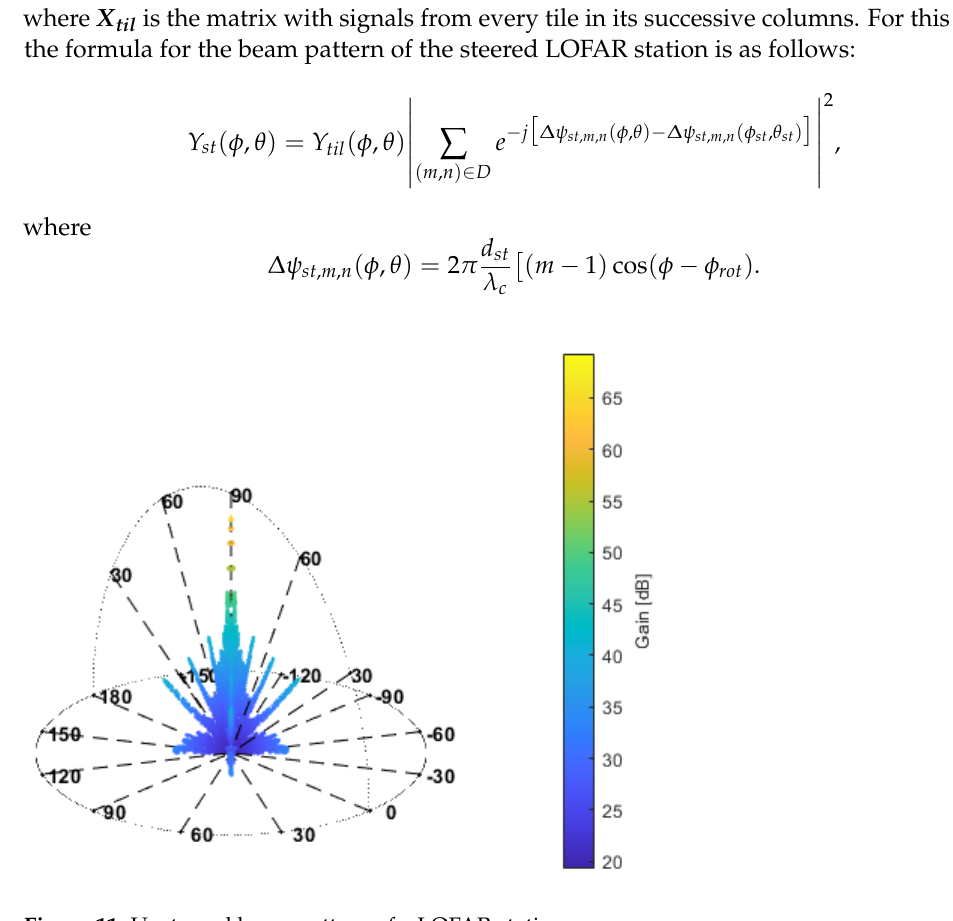
Figure 11. Unsteered beam pattern of a LOFAR